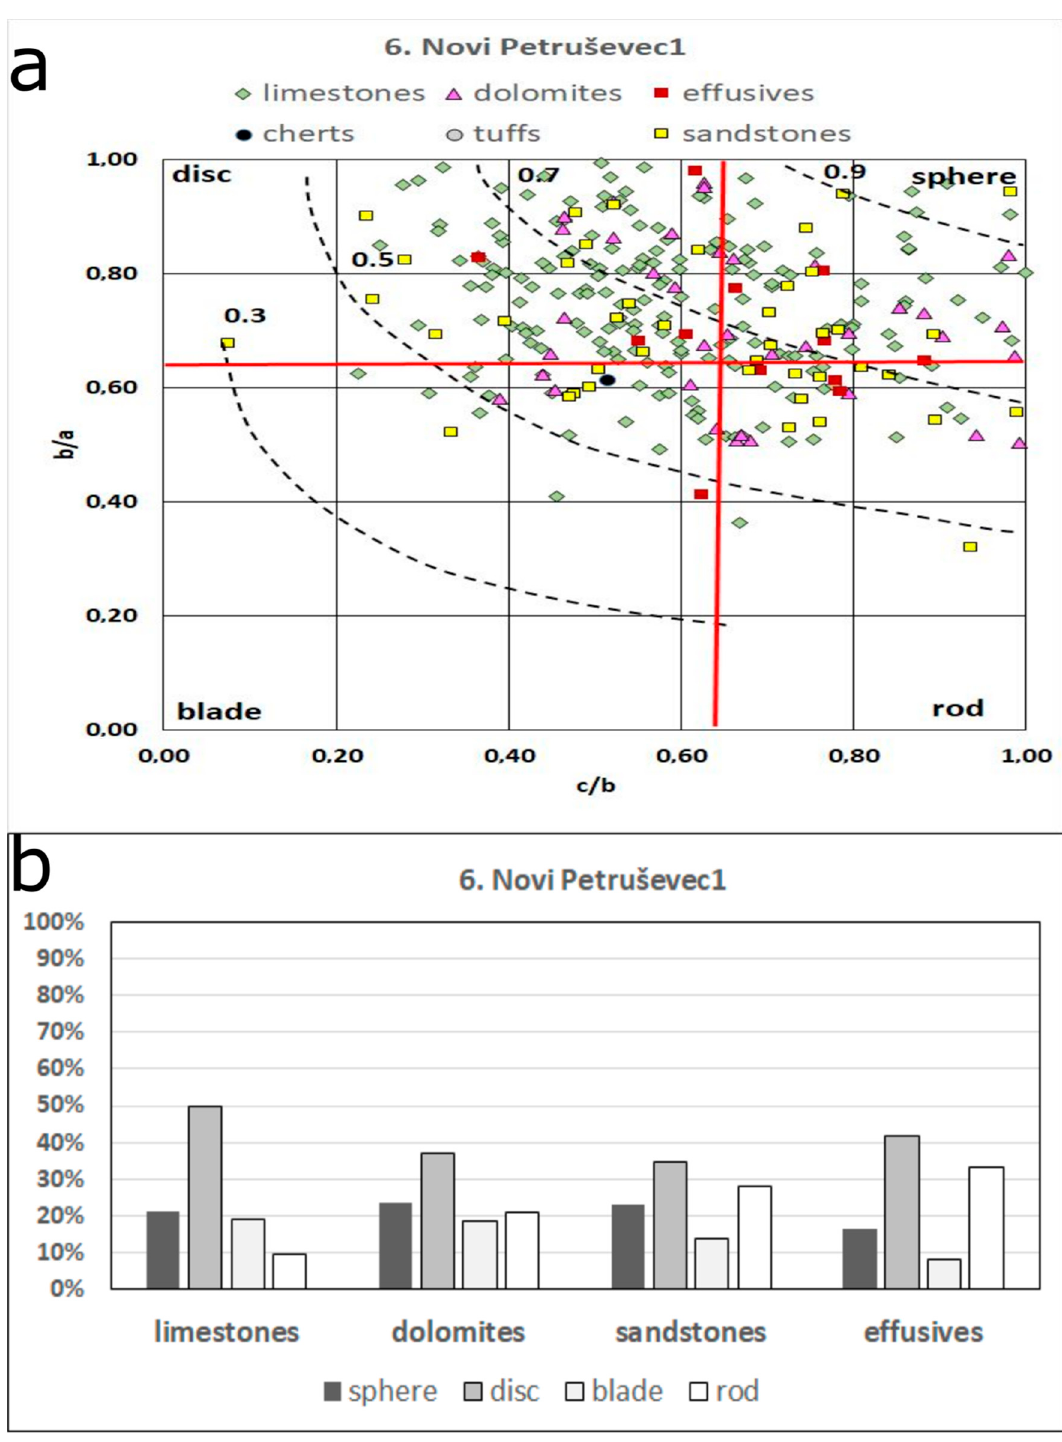
Figure 12. Pebble shapes of main lithotypes in Novi Petruševec 1: ( a ) Zingg diagram; ( b ) histograms.